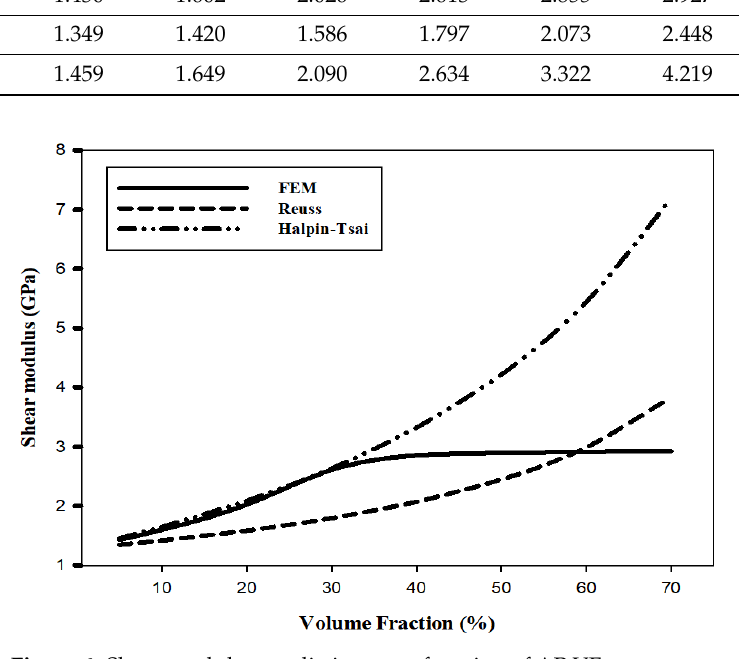
Figure 6. Shear modulus predictions as a function of AP VF.